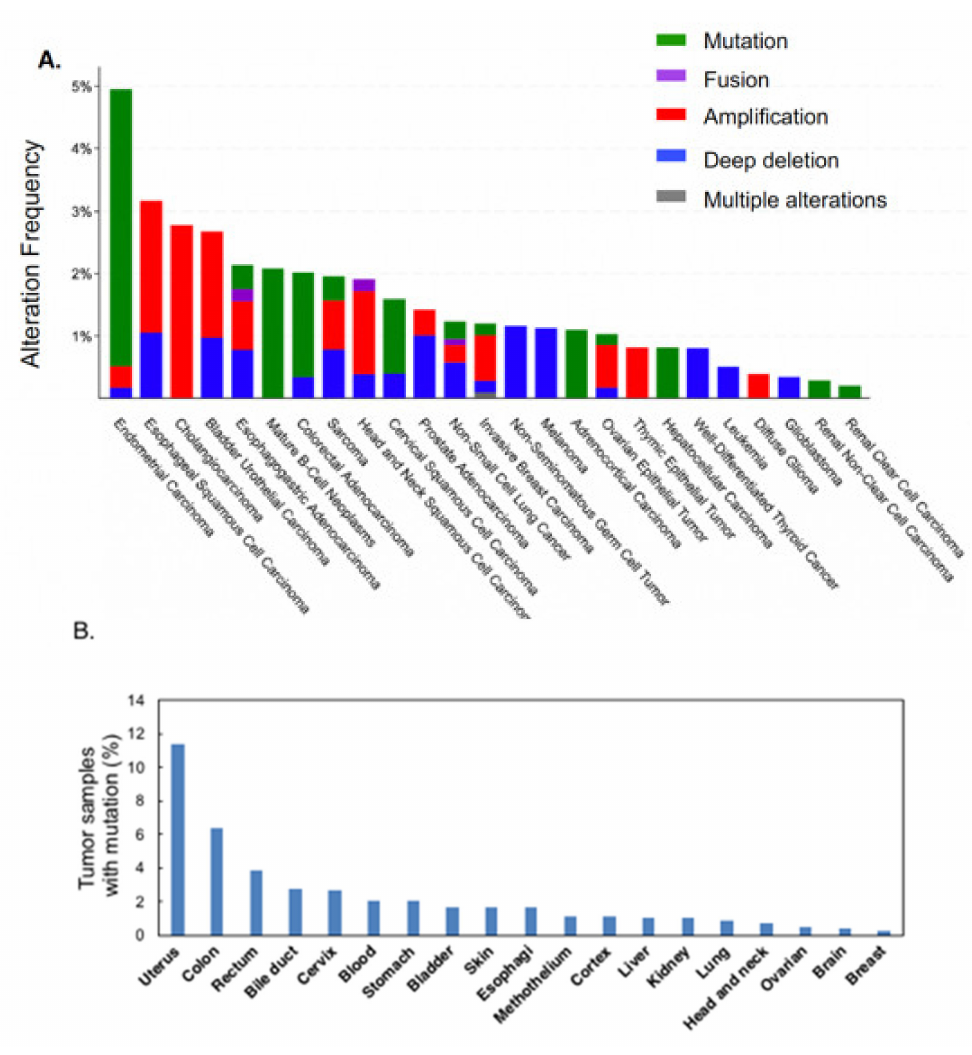
Figure 5. PARG mutation frequencies in human cancers. ( A ) The percentage of nonsynonymous mutation of PARG in each cancer in the TCGA database [40]. ( B ) The percentage of nonsynonymous substitution mutation of PARG in each cancer (total 165 mutations were listed in tumor samples from 8018 patients.) in the CanSAR database